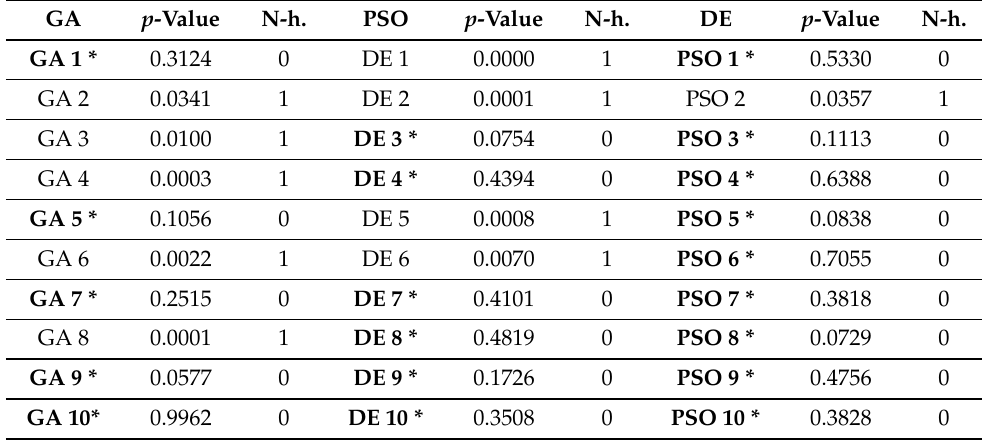
Table 5. Shapiro–Wilks test results for GA, PSO, and